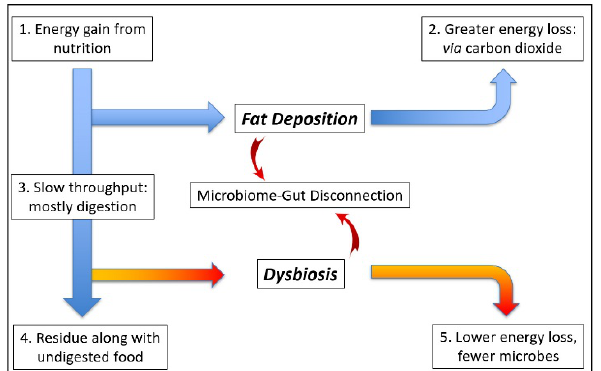
Figure 4. Microbiome–Gut Disconnection Stemming from the Neonate. Box 1 . Energy is gained by nutrition. As suggested by Burkitt, populations subject to dysbiosis are likely to benefit from lower- energy foods containing a greater proportion of dietary fibre [37]. Box 2 . The output of carbon dioxide represents the product of increased metabolism commensurate with the greater weight of a body carrying extra stored fat [4]. The increase in energy used by metabolism effectively balances the decrease in energy lost by excretion ( Box 5 ). Box 3 . In the absence of a functioning microbiome, ineffective semiochemicals means that gut motility decreases. Accordingly, most food is digested, with relatively little reaching the microbiome. Extra fat is stored in the body, until the gain in weight compensates for the lack of excretion, as described for Box 2 [4]. Box 4 . Faecal output includes indi- gestible material, along with sloughed-off cells from the digestive tract. Certain non-communicable conditions, such as coeliac disease, may lead to undigested food passing through, limiting the ab- sorption of nutrition and giving a slim and healthy appearance to the sufferer [28]. Box 5 . Faecal output contains a significant proportion of intestinal microbes. To our knowledge, energy output by this route has not been measured but is likely to be significantly reduced for heavily polluted populations, as illustrated by Figure 3b [37,52]. 5.1. Energy Homeostasis Set-point theory holds that body weight, similar to temperature and water content, is physiologically regulated through the hypothalamus, albeit, according to a 1997 review by Keesey, “shifting over a lifespan in conjunction with naturally occurring but still un- specified physiological changes” [57]. In a sense, this is the opposite of Barker’s epidemi- ological findings on what he called the “infant and fetal origins of adult disease” [38], as Keesey maintains that it is the shift of these set-points during adult life that accounts for obesity. This position has been stated in an Endocrine Society Scientific Statement of 2017, while not mentioning the microbiome at all, unless it is encompassed within the catch-all term “environment” [58]. In a similar fashion, the situation has recently been described as “broken energy homeostasis”, again with no microbial involvement recognised [59]. In a more recent article, Berthoud suggests that “… the current obesogenic environment im- pinges mainly on a critical pathway linking hypothalamic areas with the motivational and reward systems to produce uncompensated hyperphagia” [60]. It is worth noting, how- ever, that there is little ground for the existence of such widespread hyperphagia, instead coming into the category of a “common belief in obesity research”, as described by Casazza [3]. Alongside these deliberations, we have the slow realisation that gut microbi- ota exert control over important aspects of metabolism including, for example, the hypo- thalamic–pituitary–adrenal axis, and that the microbiome can, therefore, be considered to be an endocrine organ in its own right [61]. Although the wording may differ, all the above quoted authors agree that (again quoting Berthoud) “… despite significant progress in defining this complex neural circuitry, many questions remain” [60]. 5.2. A Sliding Set-Point? The fact that faecal weight has decreased alongside the industrialisation of society affords the opportunity to resolve this sliding set-point dilemma. While the hormones that provide control over aspects of behaviour are located in the brain, the microbiome is a